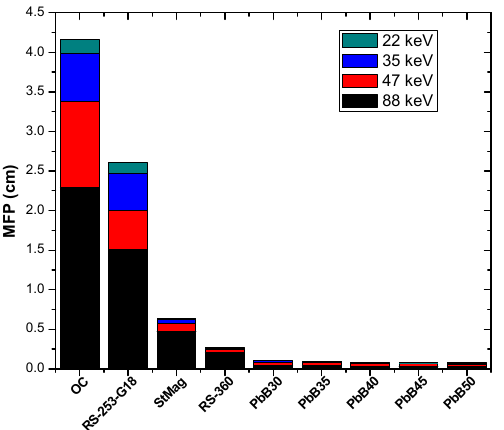
Figure 8. Comparison of MFP value of PbB30–50 glasses with those of some conventional shield at 22, 35, 47 and 88 keV.